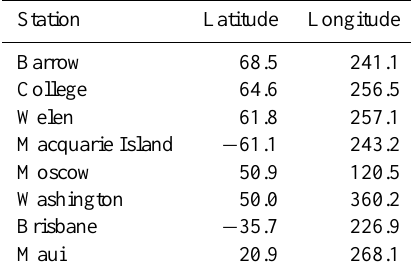
Table 1. Geomagnetic coordinates.